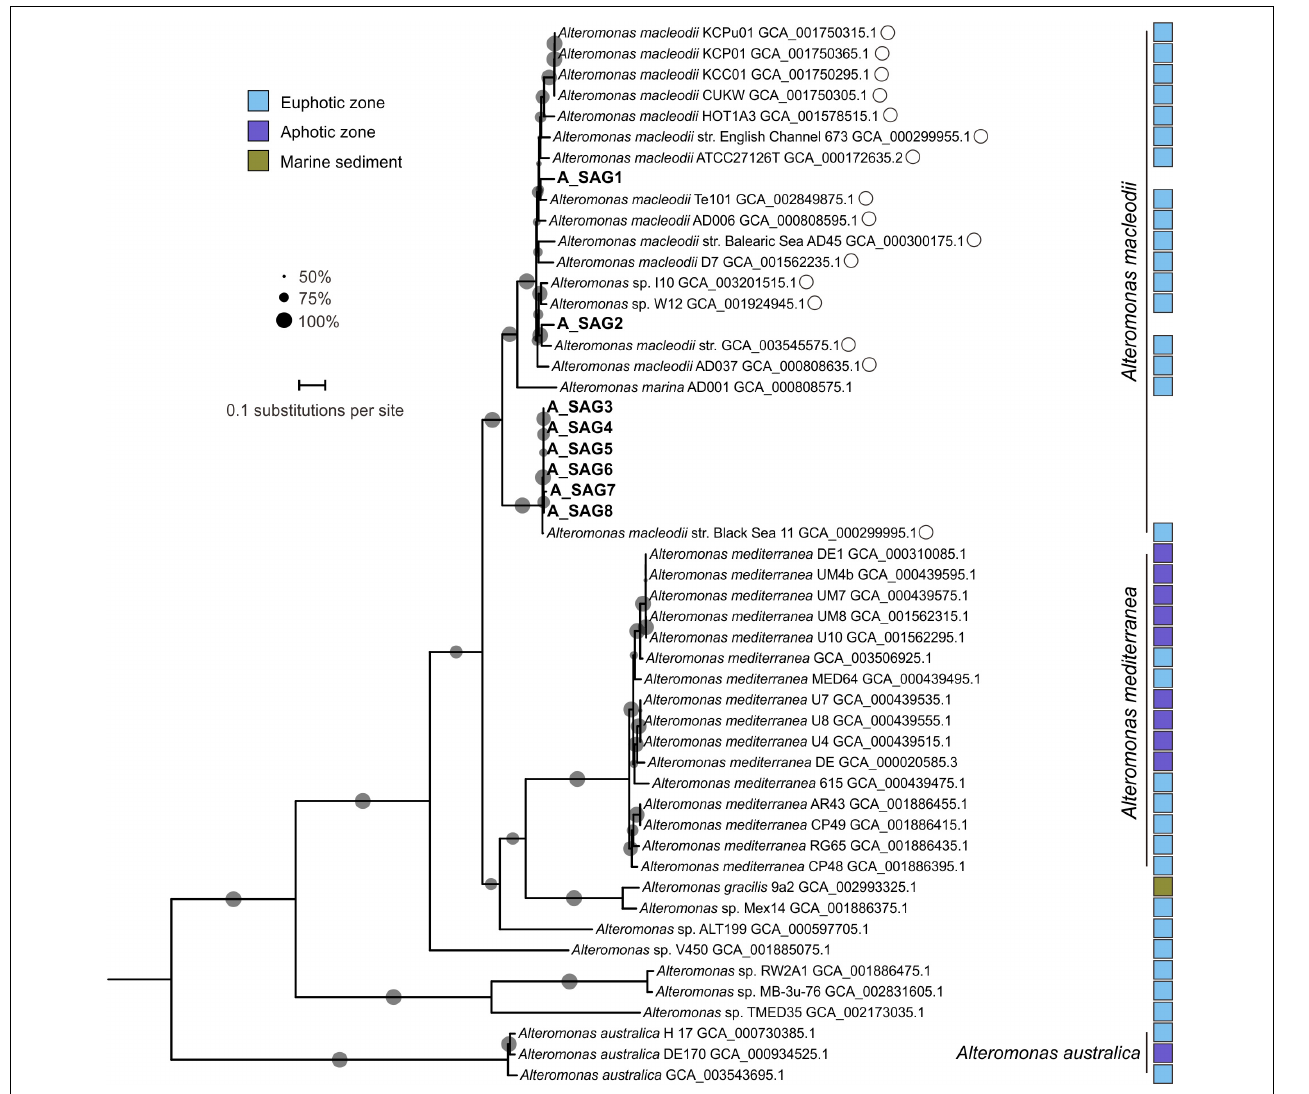
FIGURE 2 | Maximum-likelihood phylogenetic tree of the Alteromonas genomes based on amino acid sequences of 120 bacterial orthologs. The eight SAGs from this study are shown in bold. GenBank accession numbers are shown for the reference genomes. Closely related genomes with an average nucleotide identity > 95% to at least one hadal SAG from the Mariana Trench are marked with open circles. Reference genomes from different niches are marked with colored squares, as identified in the legend inset. Bootstrap values > 50% are represented in the tree with gray circles; the size of the circle is proportional to the bootstrap value. The scale bar represents the number of amino acid substitutions per